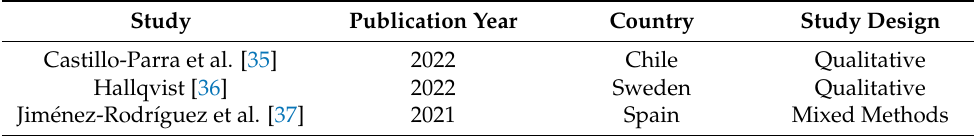
Table 1. General characteristics of included studies ( n =